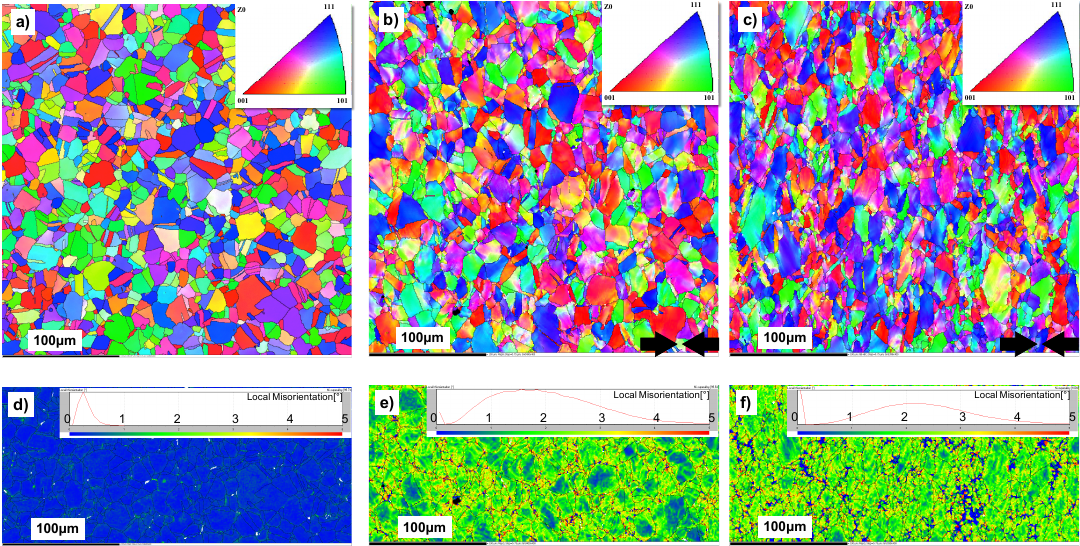
Figure 2. The microstructures of different treated IN718 samples were analyzed by EBSD: IPF maps ( a – c ) and KAM maps ( d – f ) of Base material ( a , d ), pre-deformation for 11.7% ( b , e ) and pre-deformation for 30.9% ( c , f ).